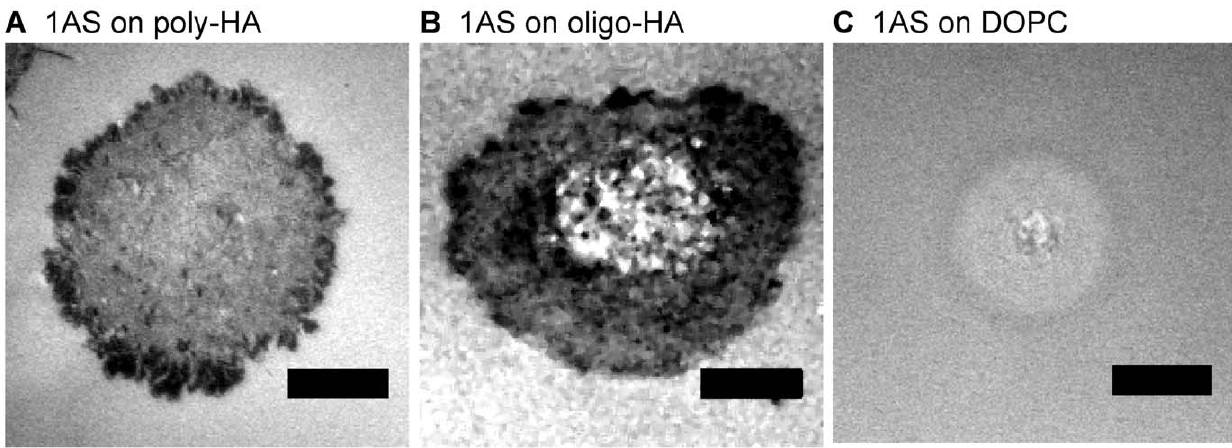
Figure 1. Cell adhesion on poly-HA and oligo-HA substrates. Micro-interferometry images of 1AS cells on supported membranes displaying (A) poly-HA and (B) oligo-HA at an average distance of , d . , 5.5 nm at t = 2 h. Scale bar: 8 m m.